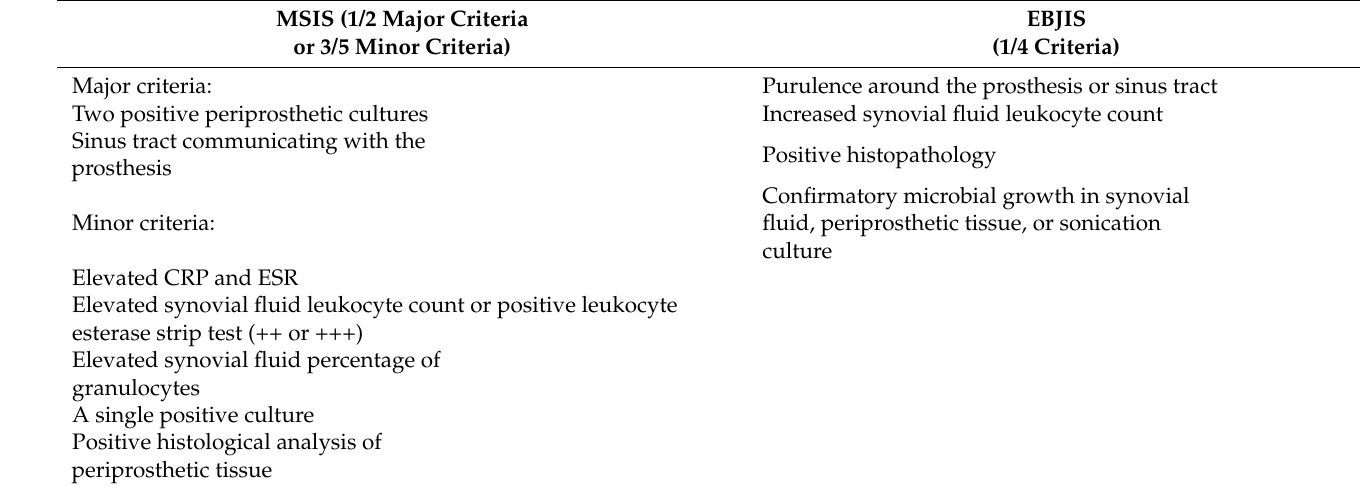
Table 1. Definition of periprosthetic joint